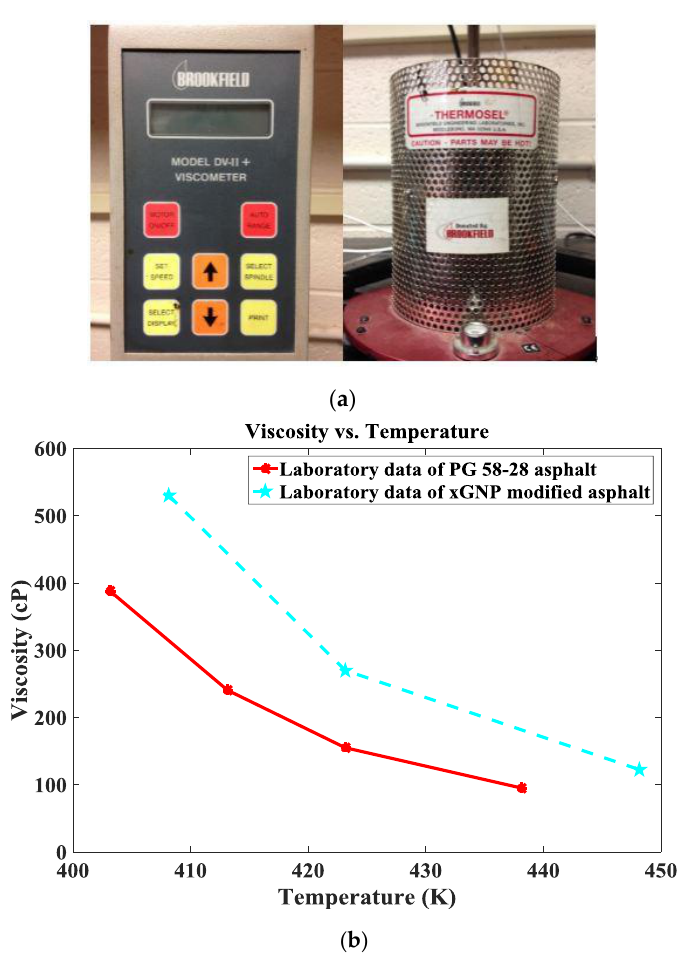
Figure 5. Laboratory results of viscosity of the control and xGNP modified asphalt binders. ( a ) Brookfield DV-II plus viscometer for testing viscosity of asphalt; ( b ) viscosities of the control (PG 58-28) and xGNP modified asphalt binders.